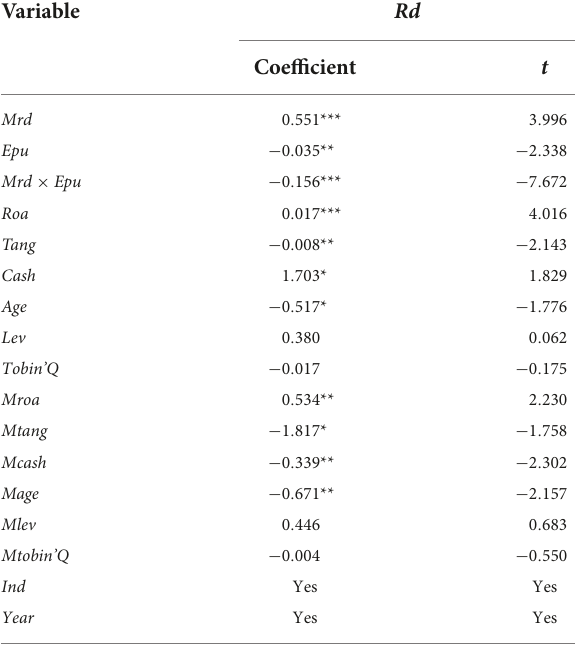
TABLE 6 Moderating effect of economic policy